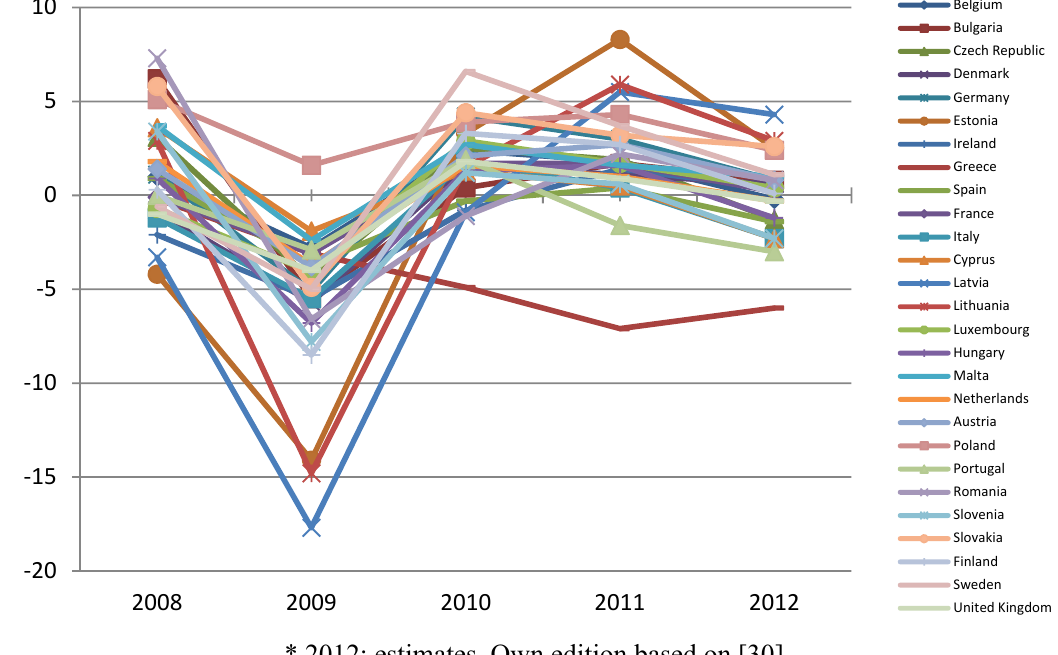
* 2012: estimates. Own edition based on [30]. Figure 6. GDP per capita in PPS of Eurozone countries, 1999–2011 *, EU27 = 100.